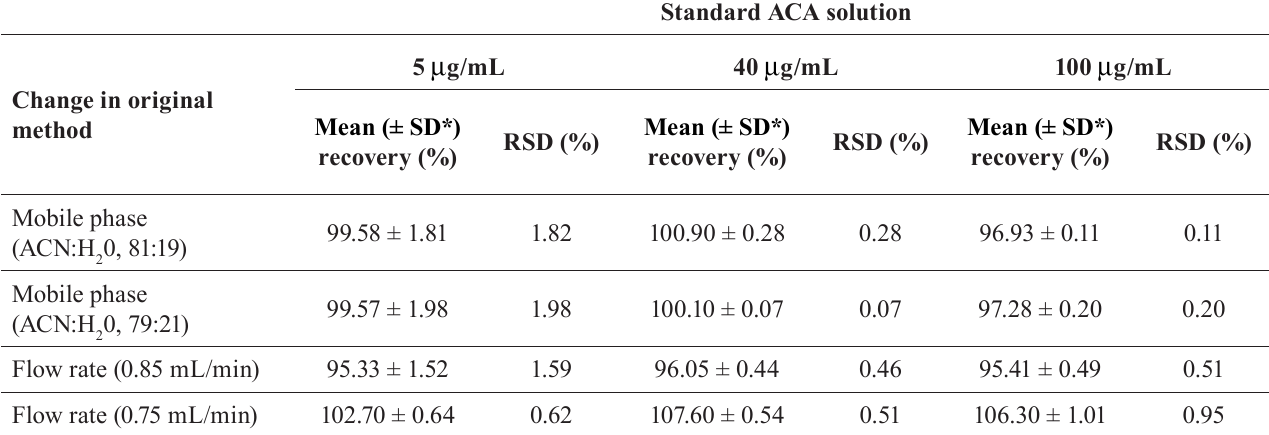
TABLE V - R obustness results according to changes in mobile phase and flow